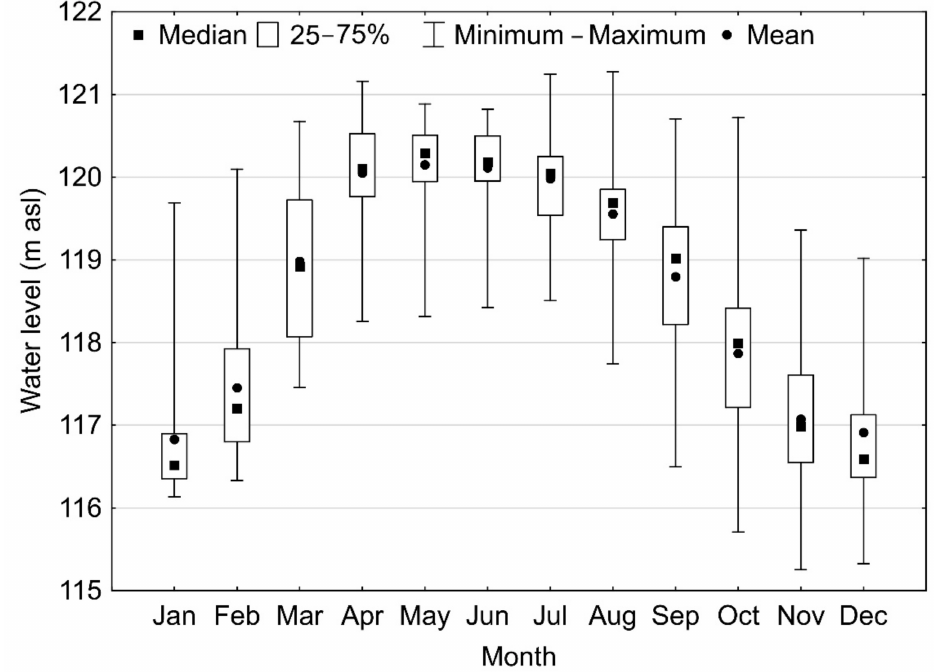
Figure 4. Distribution of mean monthly water levels in the Jeziorsko